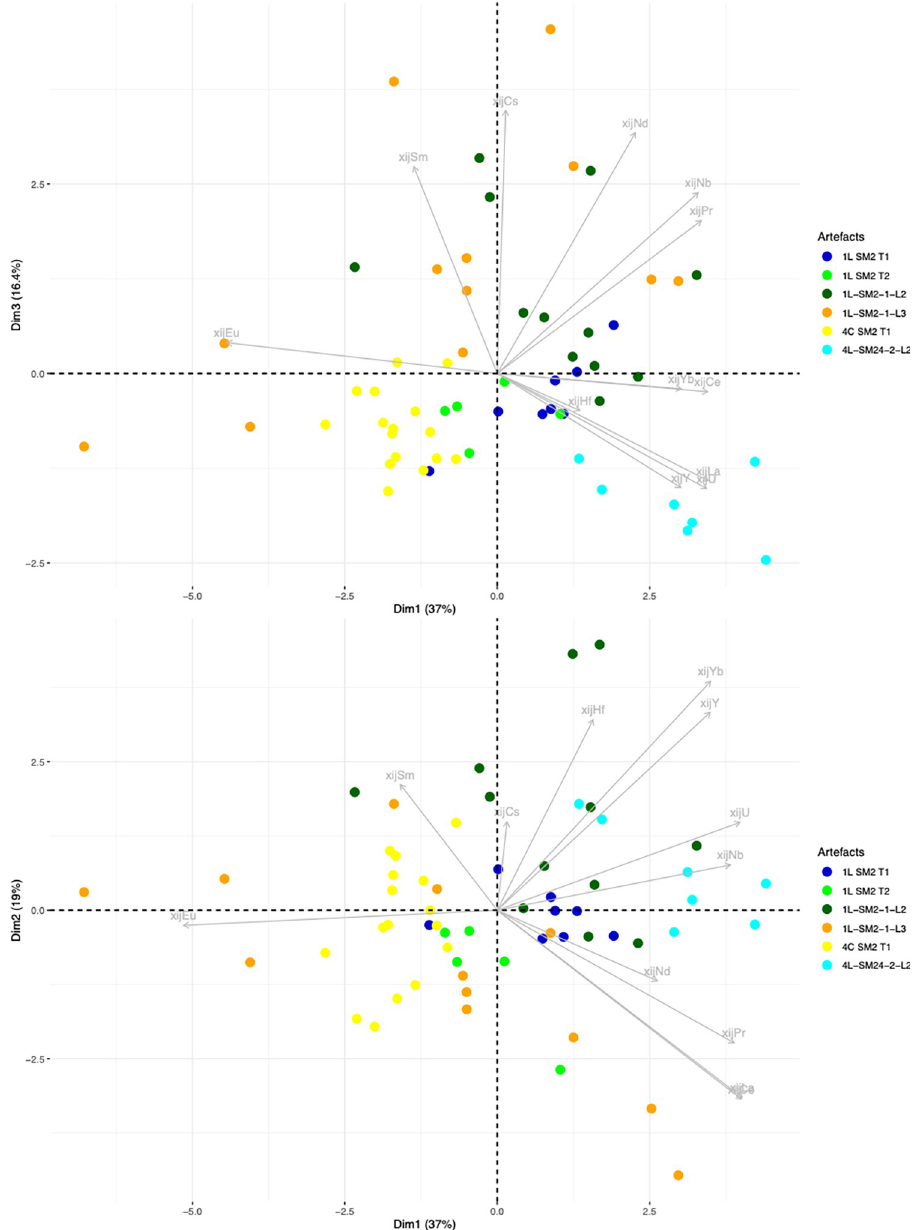
Fig 18. Stage 2 in statistical inference, PCA of the artefact group G1 (stage 1 of statistical inference). % of total